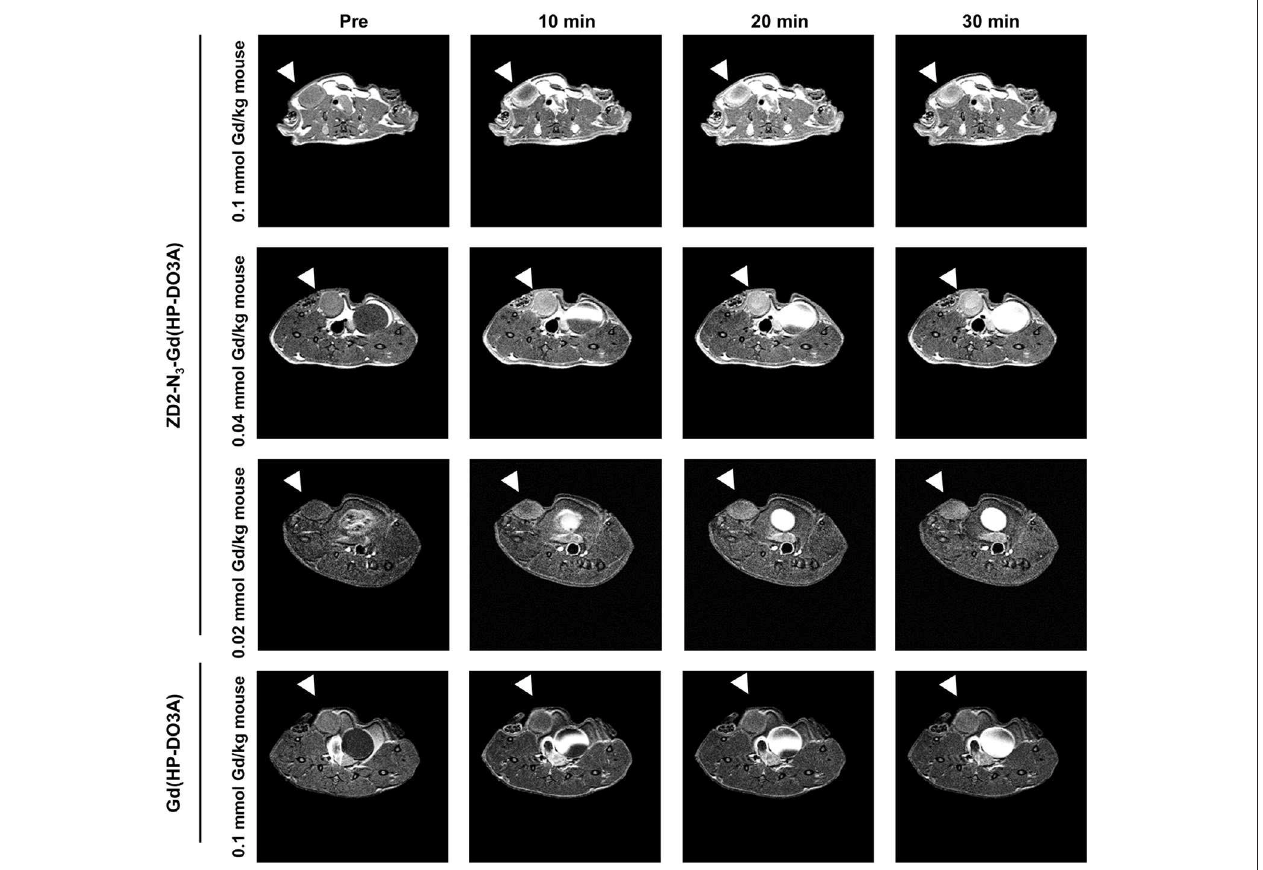
FIGURE 2 | MRMI with MT218 of MDA-MB-231 tumors in mice. Representative axial T 1 -weighted 2D fast spin echo images taken before and at 10, 20, and 30min post-injection of MT218 at doses of 0.1, 0.04, and 0.02 mmol Gd/kg mouse. Tumors are indicated by the white arrow heads. The clinical agent Gd(HP-DO3A) was used as a control at 0.1 mmol